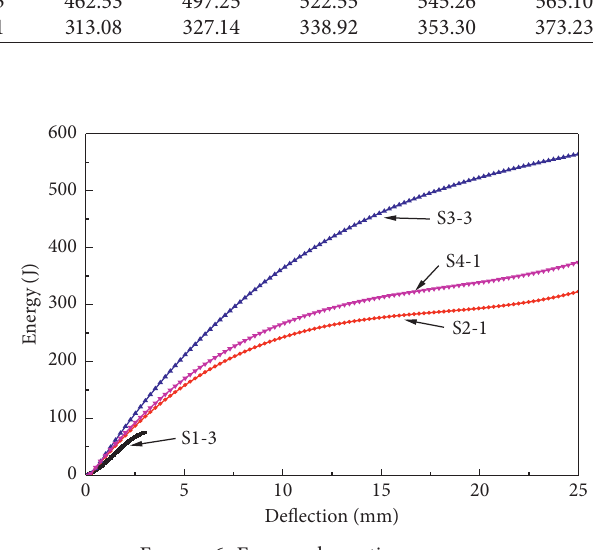
Figure 6: Energy absorption